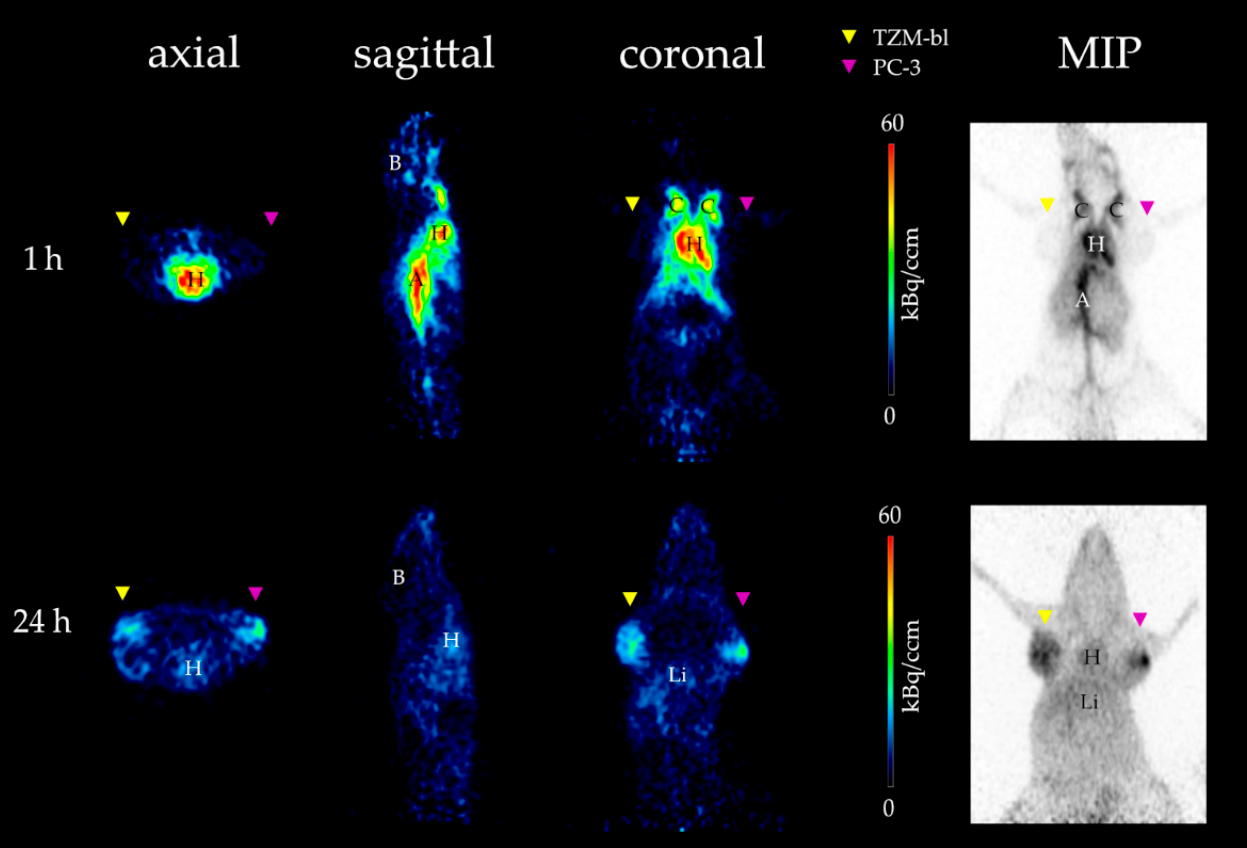
Figure 3. Image of [ 89 Zr]Zr-DFO-HSA biodistribution in tumor-bearing mice by PET 1 h and 24 h p.i. Depicted are the three different section planes (axial, sagittal, and coronal) and the corresponding maximum intensity projection ( right ). After 1 h ( top row ), most of the radioactivity can be detected in the heart (H), aorta (A), and carotids (C). Within the two tumors (TZM-bl, yellow arrow, and PC-3, magenta arrow), as well as in the brain (B), little to no activity can be detected. After 24 h ( bottom row ), both tumors display a high activity level, whereas in the heart and liver (Li), only a moderate signal can be detected. Brain, joints, and kidneys are clear of radioactivity at 1 h and still after 24 h p.i., suggesting that there are no relevant amounts of free 89 Zr due to the high stability of the compound. Thus, [ 89 Zr]Zr-DFO-HSA accumulates only in regions affected by the EPR effect and shows similar results as in the CAM model.